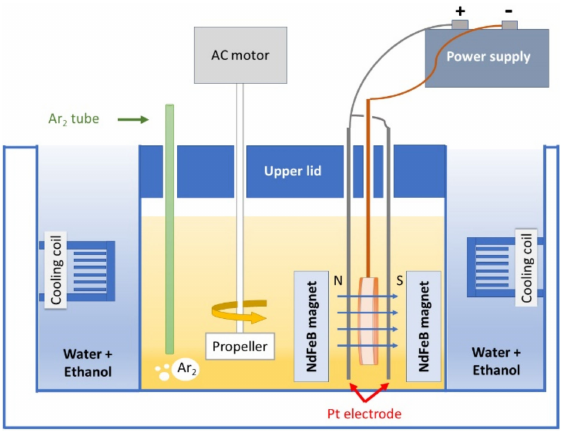
Figure 1. Schematic diagram of the electrodeposition cell. The Cu seed layer was electroplated in 100 mL solution with 9 g of Cu 2 P 2 O x · x H 2 O, 34.5 g of K 4 O 7 P 2 , and 0.3 mL of NH 4 OH at the temperature of 333 K with a DC current density of 40 mA/cm 2 for 20 min, and the Ni 50 Mn 33 In 16 Cr 1 pellet with a diameter